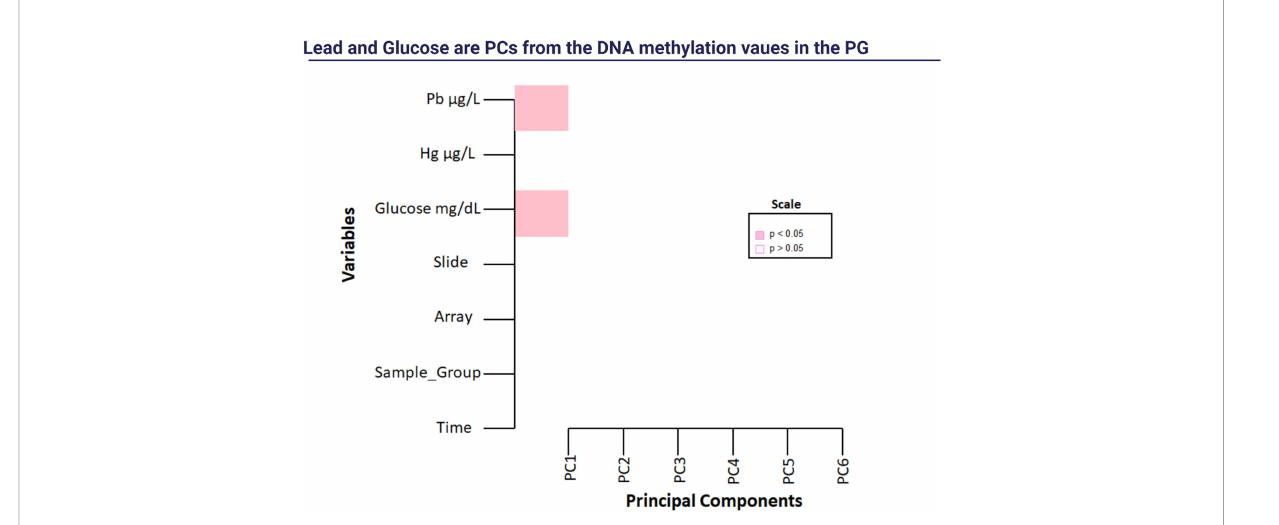
FIGURE 2 Singular Value Decomposition Analysis (SVD). Note: Pb: lead; Hg: